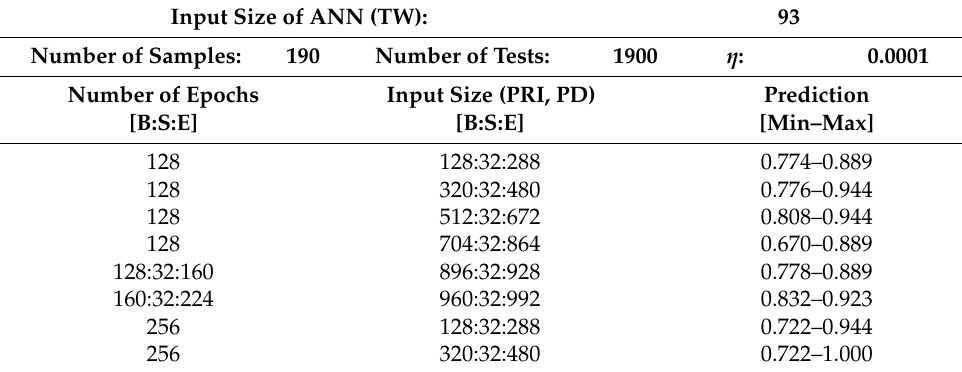
Table 10. Effectiveness of signal recognition using the CNN on the basis of simultaneous analysis of 2 parameters PRI, PD and TW vectors.